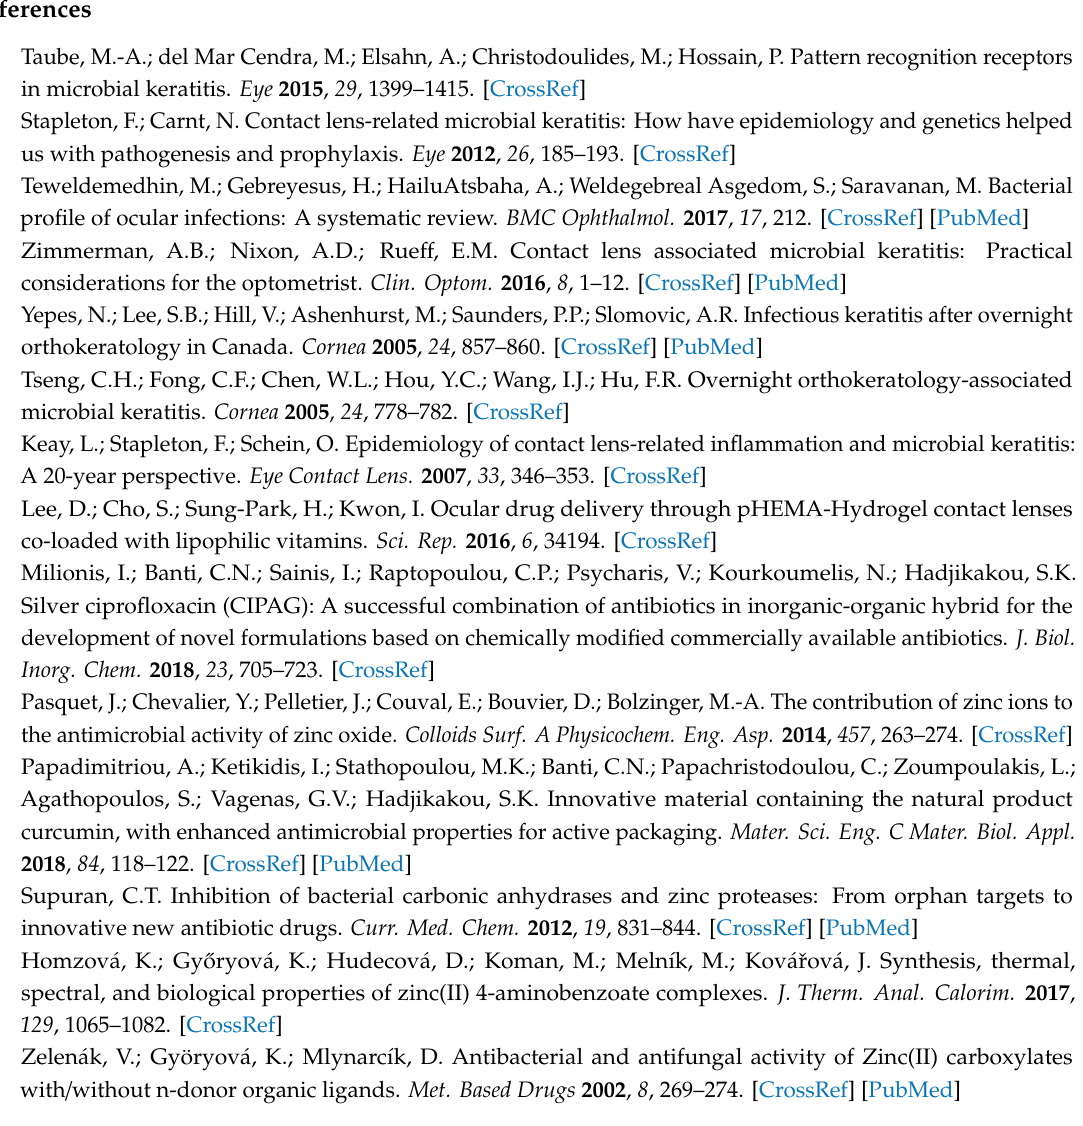
E. coli ; Figure S10. Minimum bactericidal concentration of 1 (A), 2 (B), SLS (C), CitH 4 (D) against St. epidermidis .; Figure S11. Results from MBC assay with of 1 (A), 2 (B), SLS (C), CitH 4 (D) against St. aureus ; Figure S12. Results from MBC assay with of 1 (A), 2 (B), SLS (C), CitH 4 (D) against PAO1 ; Figure S13. Results from MBC assay with of 1 (A), 2 (B), SLS (C), CitH 4 (D) against E. coli ; Figure S14. Biofilm inhibition of St. aureus versus increasing concentrations of 2 . The trend line function that fits better to the points (higher R 2 parameter) from which the BEC value is determined, is also shown in this